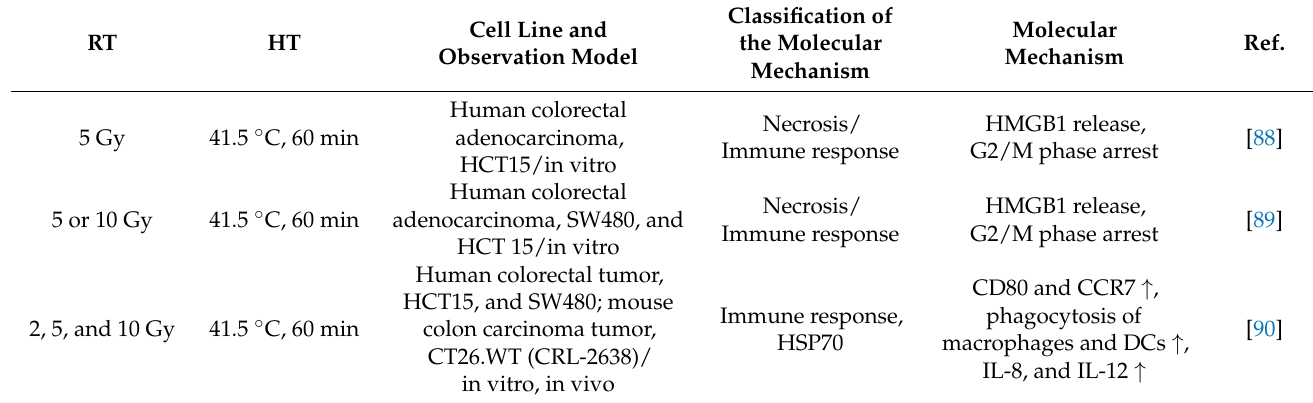
Table 3. RT + HT induces the immune response in tumor